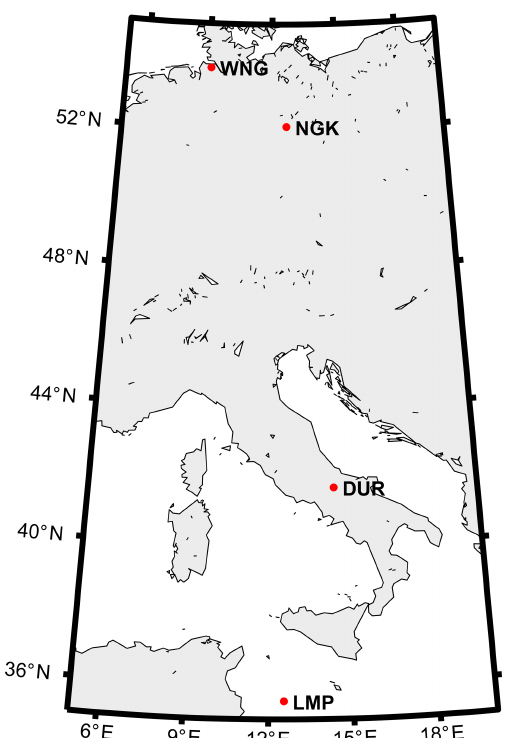
Figure 1. European geomagnetic observatories used in this